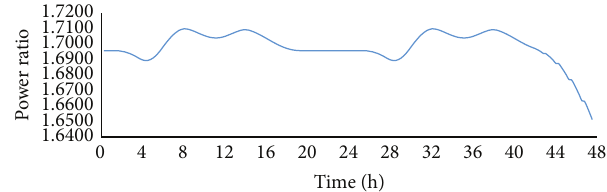
Figure 4: Trend of the power ratio at the initialization of the ascent phase.